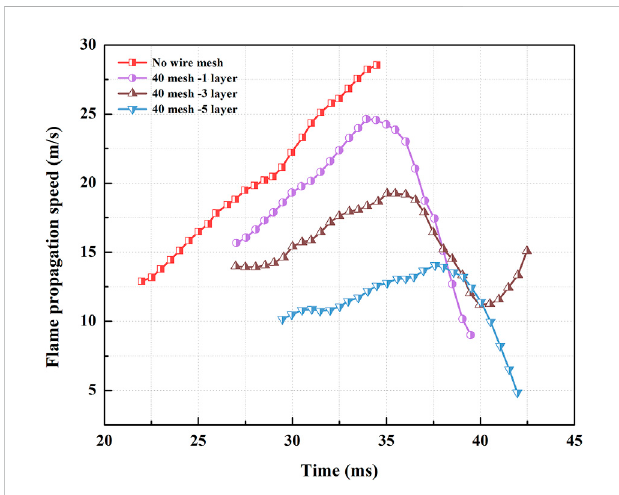
FIGURE 5 Flame front propagation velocity under different wire mesh